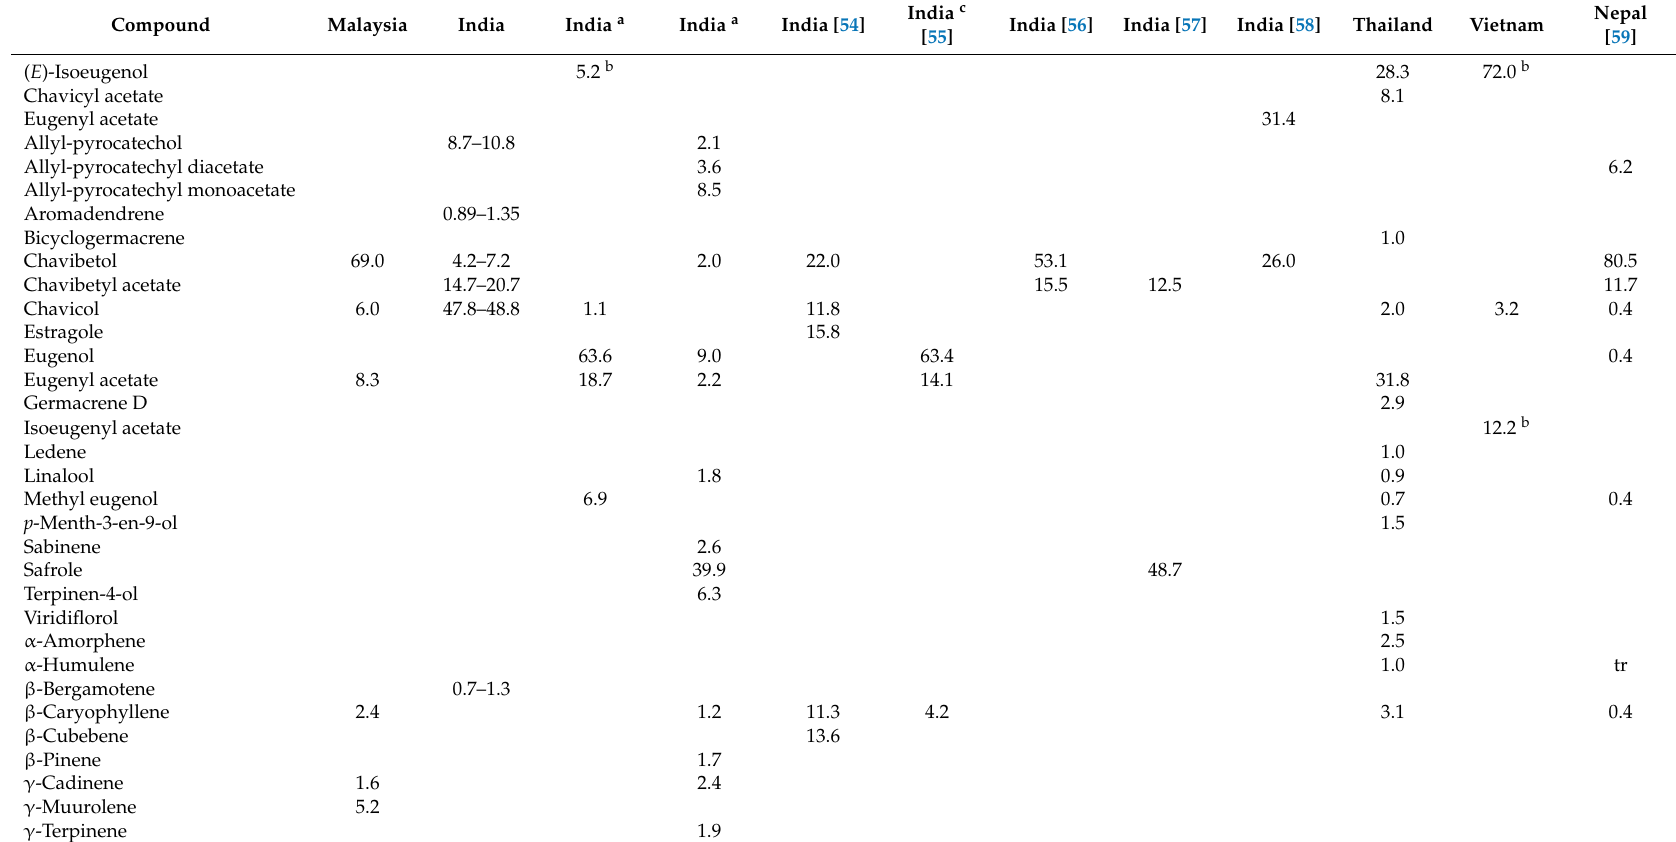
Table 7. Chemical compositions (%) of Piper betle leaf essential